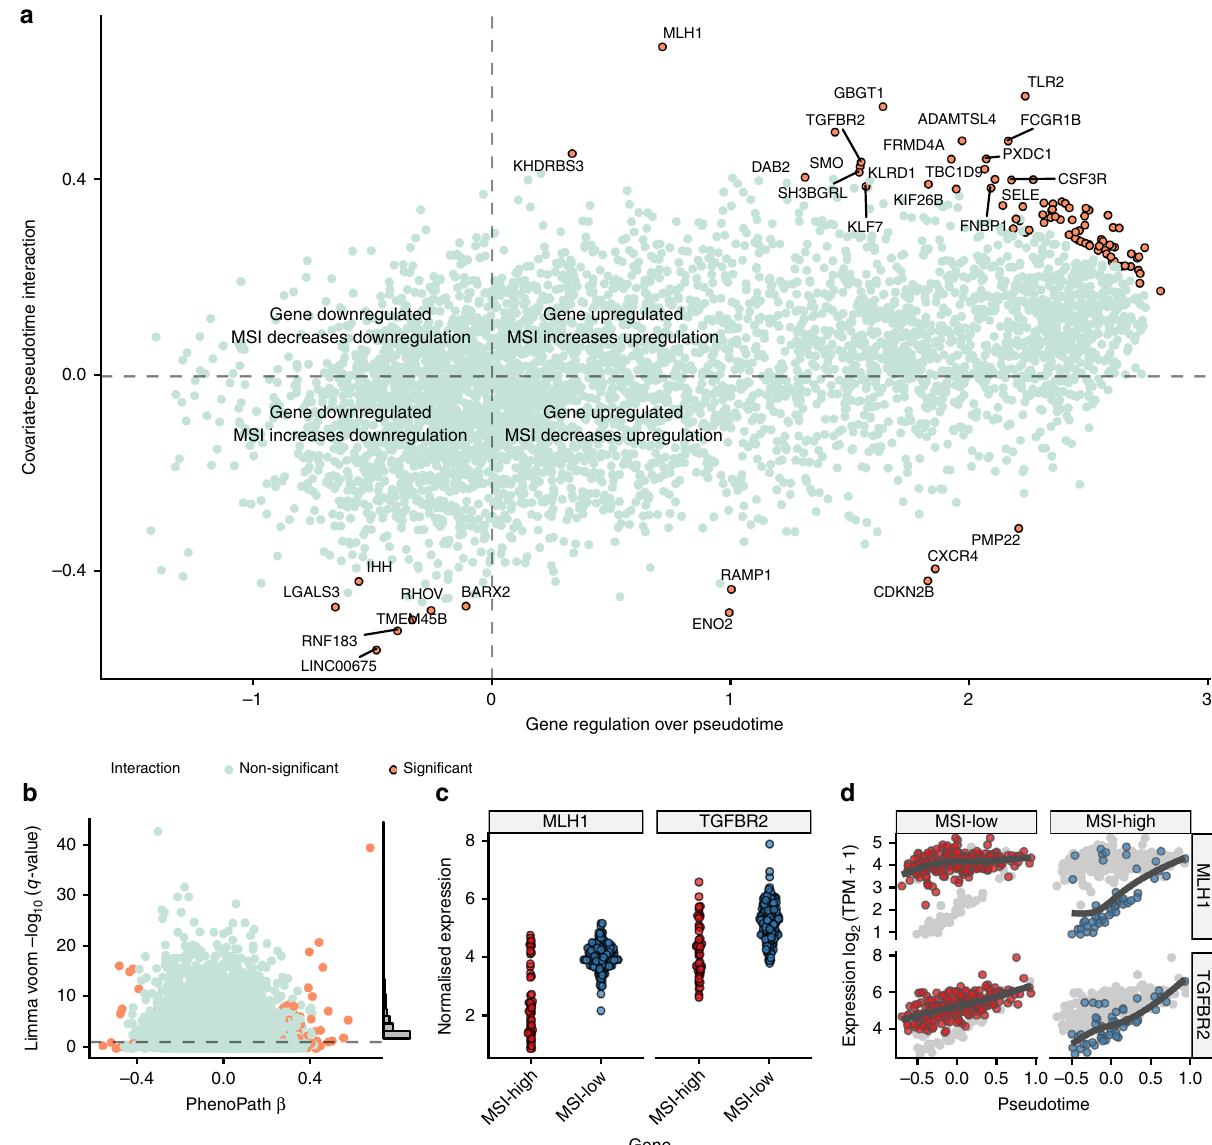
Fig. 5 Immune-microsatellite instability interactions in colorectal adenocarcinoma. a PhenoPath applied to colorectal adenocarcinoma (COAD) RNA-seq expression data uncovers a landscape of interactions between the inferred immune trajectory and microsatellite instability status (MSI). b A comparison to the FDR-corrected q -values reported by Limma Voom demonstrates genes found interacting with MSI status and the immune pathway are found to be both DE and non-DE in standard analyses. c Standard differential expression analysis masks the relationship between immune response and microsatellite instability in the expression of MLH1 and TGFBR2 . d Using PhenoPath pseudotime the expression of MLH1 and TGFBR2 were identi fi ed as being signi fi cantly perturbed along the immune trajectory by MSI status. MLH1 shows no interaction with immune pathway activation in the MSI-low regime yet is highly correlated with immune pathway activation in the MSI-high